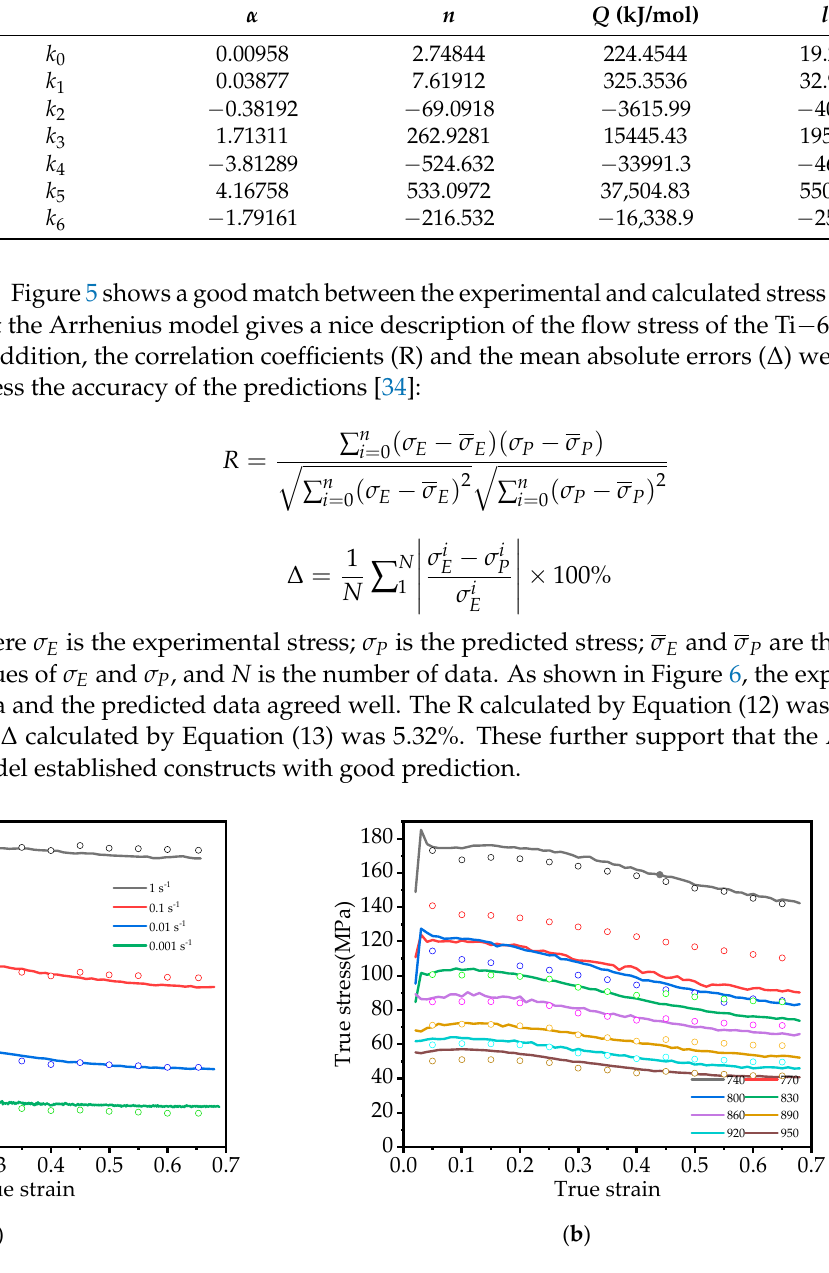
Figure 6. Correlation analysis of the experimental and predicted flow stress under all conditions of the Ti − 65541 alloy. 3.3. Hot Processing Map Thermal processing diagrams are often used to synthesize and evaluate the pro- cessing performance of materials to optimize the optimal processing parameters. Prasad et al. [35] proposed the dynamic materials model (DMM) for generating the thermal pro- cessing map by superimposing the plastic instability map over the power dissipation map. The total power input (P) to the system during thermal compression may be described as the following, using the law of thermodynamics: P = 𝜎𝜀(cid:4662) = G + J = (cid:1516) 𝜎 (cid:3084)(cid:4662) (cid:2868) d 𝜀(cid:4662) + (cid:1516) 𝜀(cid:4662) (cid:3097) (cid:2868) d 𝜎